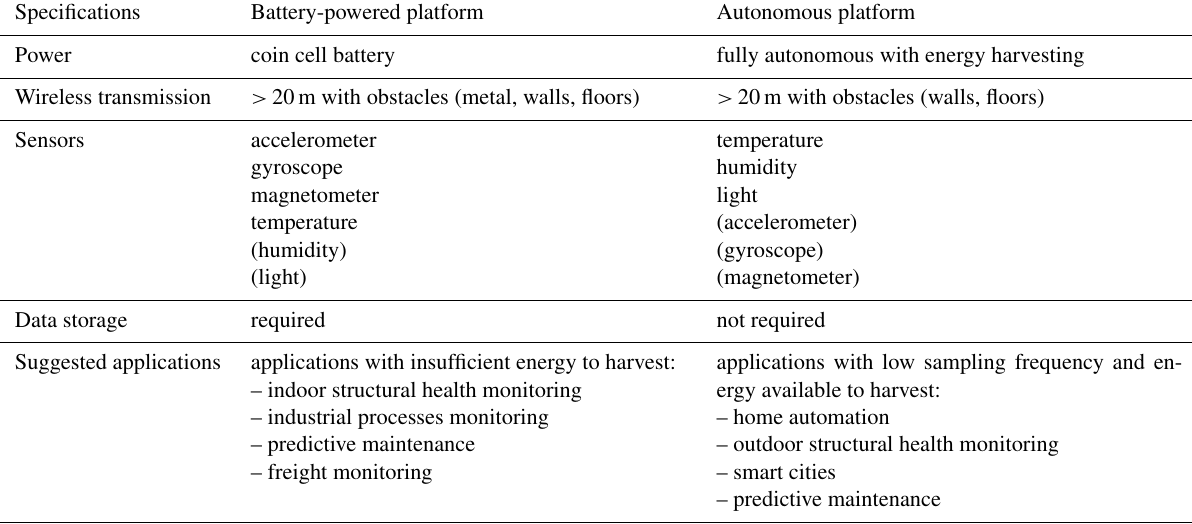
Table 2. Summary of specifications for the battery-powered and the autonomous platforms. Optional sensors are listed in brackets. Specifications